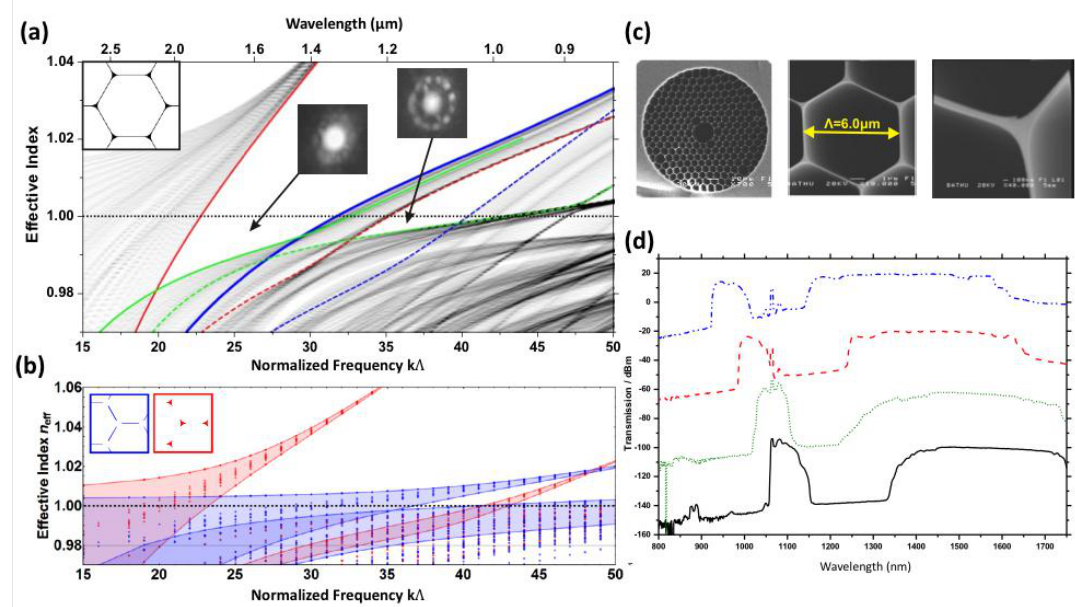
Figure 11. ( a ) Density of photonic states for the cladding structure illustrated inset top-left with a strut thickness of t = 0.01 Λ and apex meniscus curvature of r = 0.15 Λ . The colored lines trace the cladding modes that form the edges of the two bandgaps. The wavelength in the upper x-axis is deduced for a pitch of 6.7 µ m. ( b ) Evolution of the cladding modes of apexes alone (red) and struts alone (blue). ( c ) SEMs showing the fiber cross-section and the cladding structure. ( d ) Transmission spectra of 5 m lengths of the fabricated HCPCF with varying pitch, offset vertically for clarity (Reprinted with permission from Reference [74], OSA,